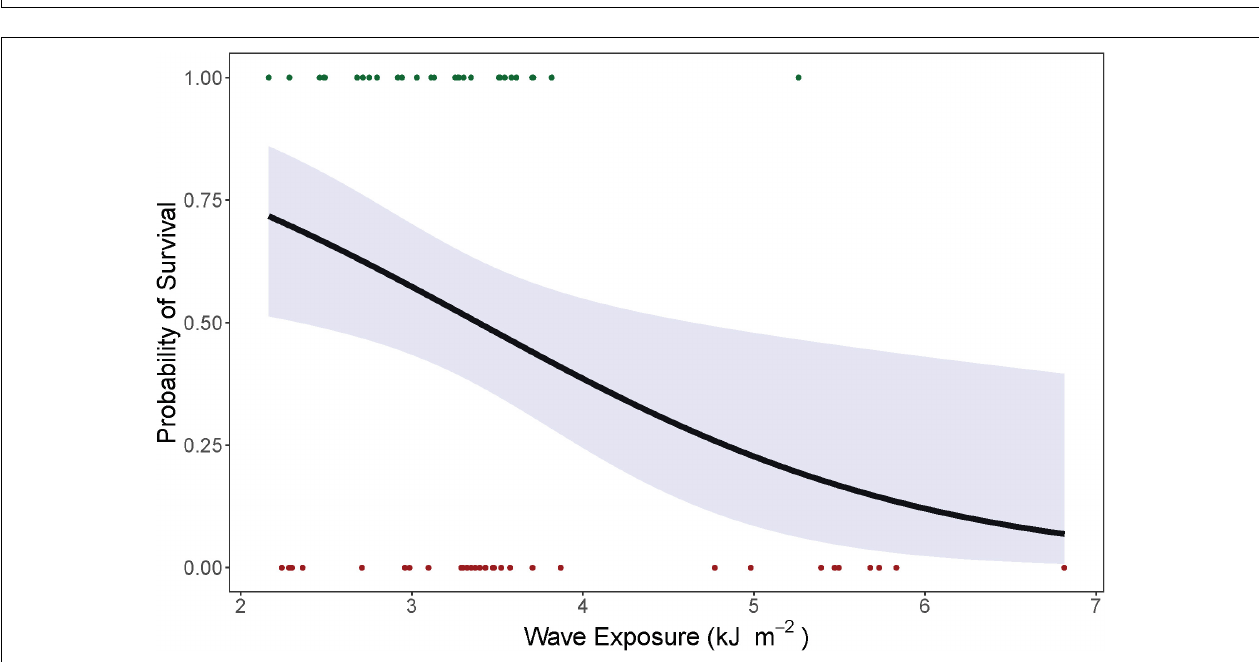
FIGURE 2 | Location of the top-ranked 33 reefs (depicted by yellow circles) with the highest likelihood of survival of Acropora cervicornis outplants, and the bottom-ranked 34 reefs (depicted by black circles) with the lowest likelihood of survival for A. cervicornis outplants in 7 subregions along the Florida reef tract, United States from 2012 to 2018—based on the posteriori mean values using “reef” as the fixed effect in the Integrated Nested Laplace Approximation (INLA) model.